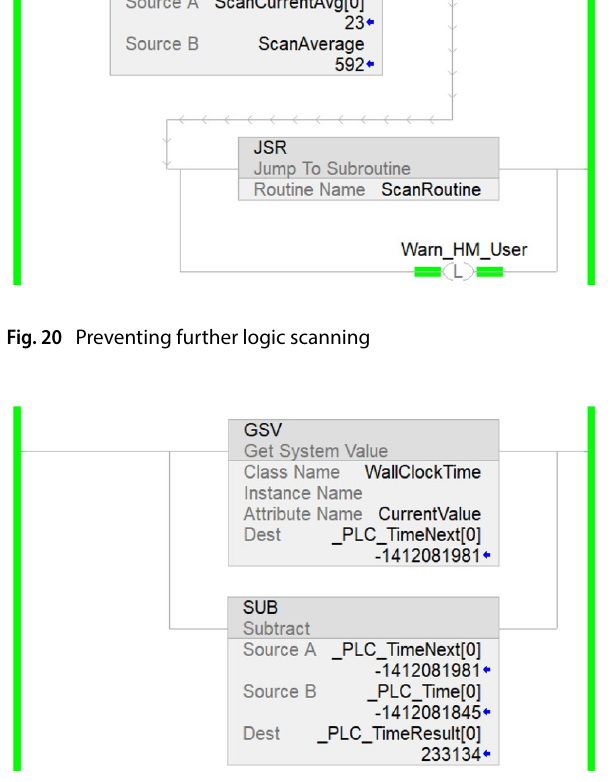
Fig. 21 The scan time was significantly increase after inserting “For” loop instruction